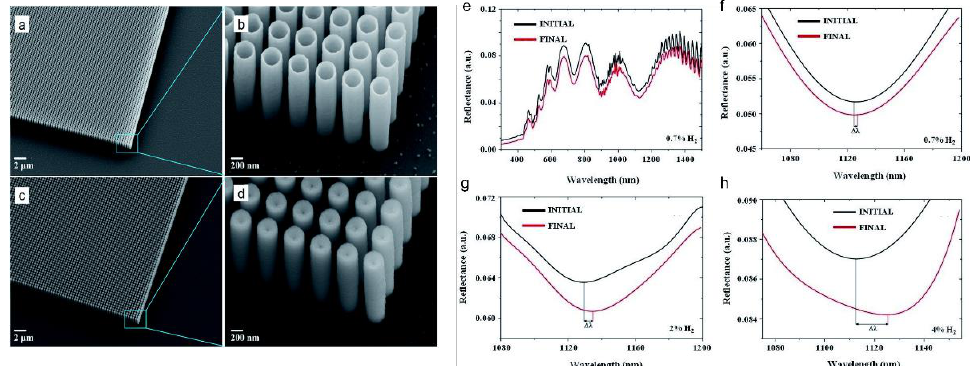
Figure 10. Scanning electron microscope (SEM) images of the fabricated AZO ( a , b ) nanotube and ( c , d ) pillar structures with a pitch of 400 nm, the diameter of 300 nm and height of 2 µm. The wall thickness of nanotubes is approximately 20 nm. ( e ) The response of the AZO nanotubes before and after intercalation of 0.7% H 2 gas and upon exposure to ( f ) 0.7% H 2 , ( g ) 2% H 2 and ( h ) 4% H 2 gas at the wavelength range of λ = 300– 1500 nm [114] © The Royal Society of Chemistry 2020. Table 2. Performance comparison of metamaterial-based gas sensors.